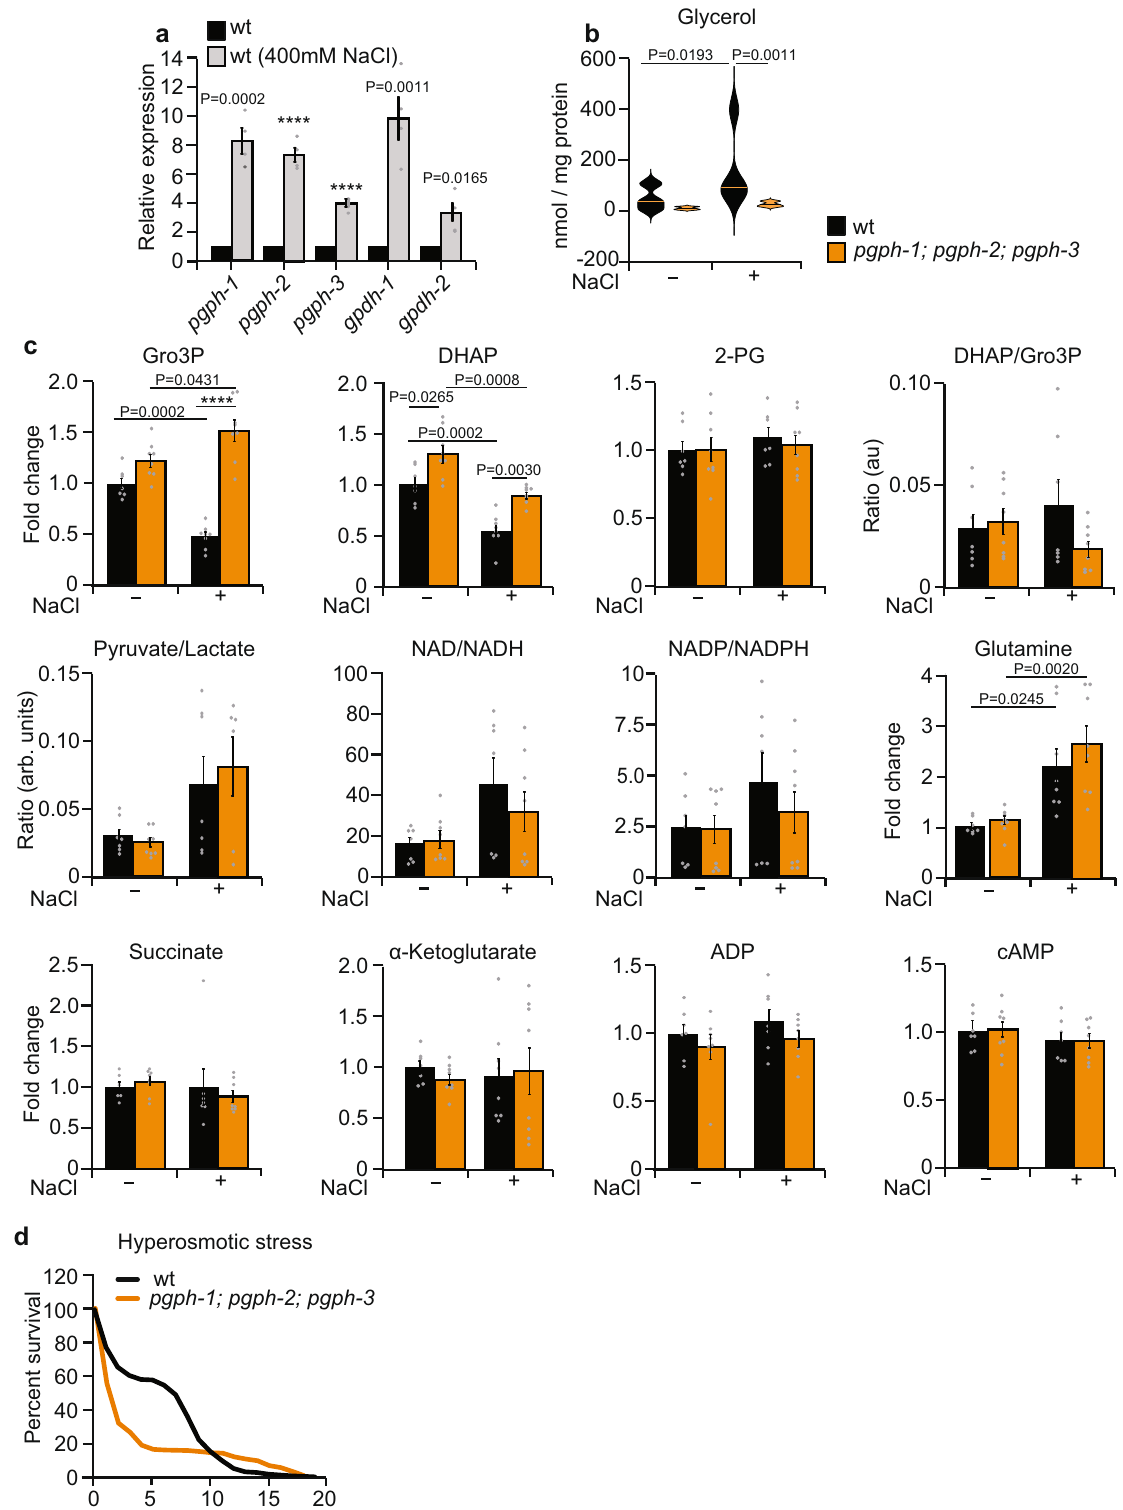
hypersensitive to hyperosmotic stress (Supplementary Fig. 6k-m). pgph mutant animals were not signi fi cantly different under nor- Pre-treatment of the worms with 2% glucose or 1% glycerol mal growth conditions or following hyperosmotic stress or excess increased the survival of the animals to 400 mM NaCl (Fig. 4d – f glucose (Supplementary Fig. 6g – i). Oil red O staining revealed a and Supplementary Fig. 6n – p and Supplementary Data 1) and similar increase in fat levels in the double and triple pgph both double and triple pgph mutant animals pretreated with 2% mutants, driven by elevated lipogenesis (Supplementary Fig. 6j). glucose or 1% glycerol were hypersensitive in comparison to the Moreover, double and triple pgph mutant animals were equally NATURE COMMUNICATIONS| (2022) 13:177